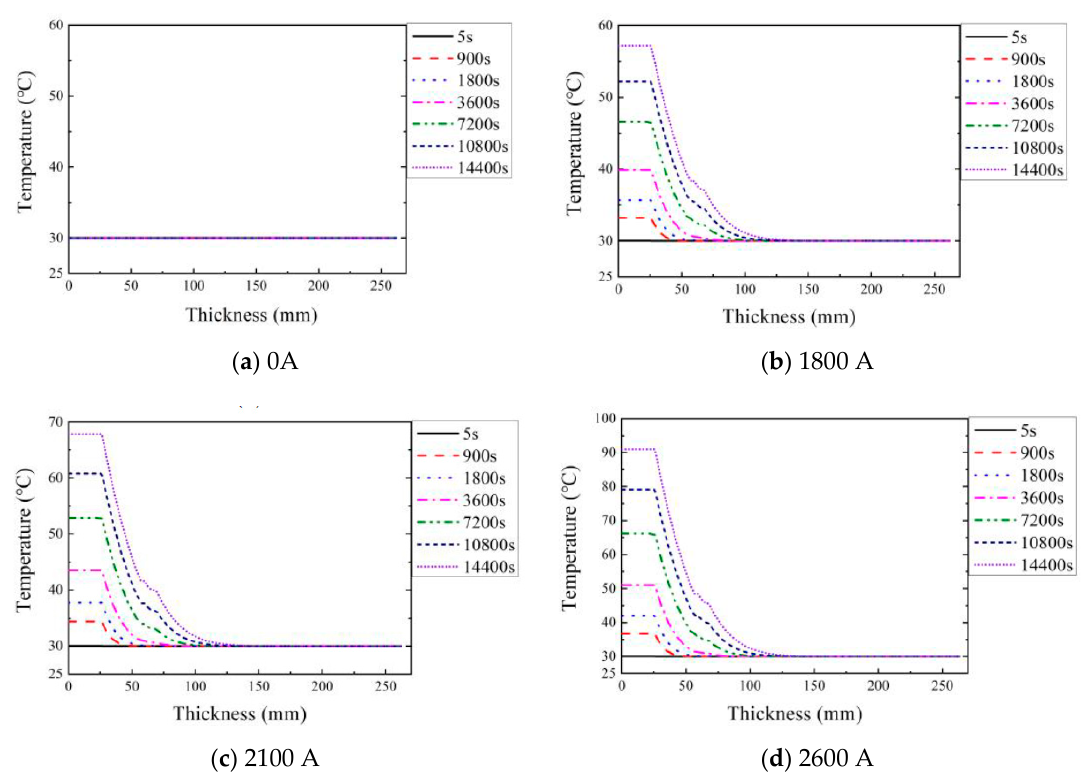
Figure 9. Temperature distribution of 320 kV HVDC cable with load currents of 0, 1800, 2100 and 2600 A.